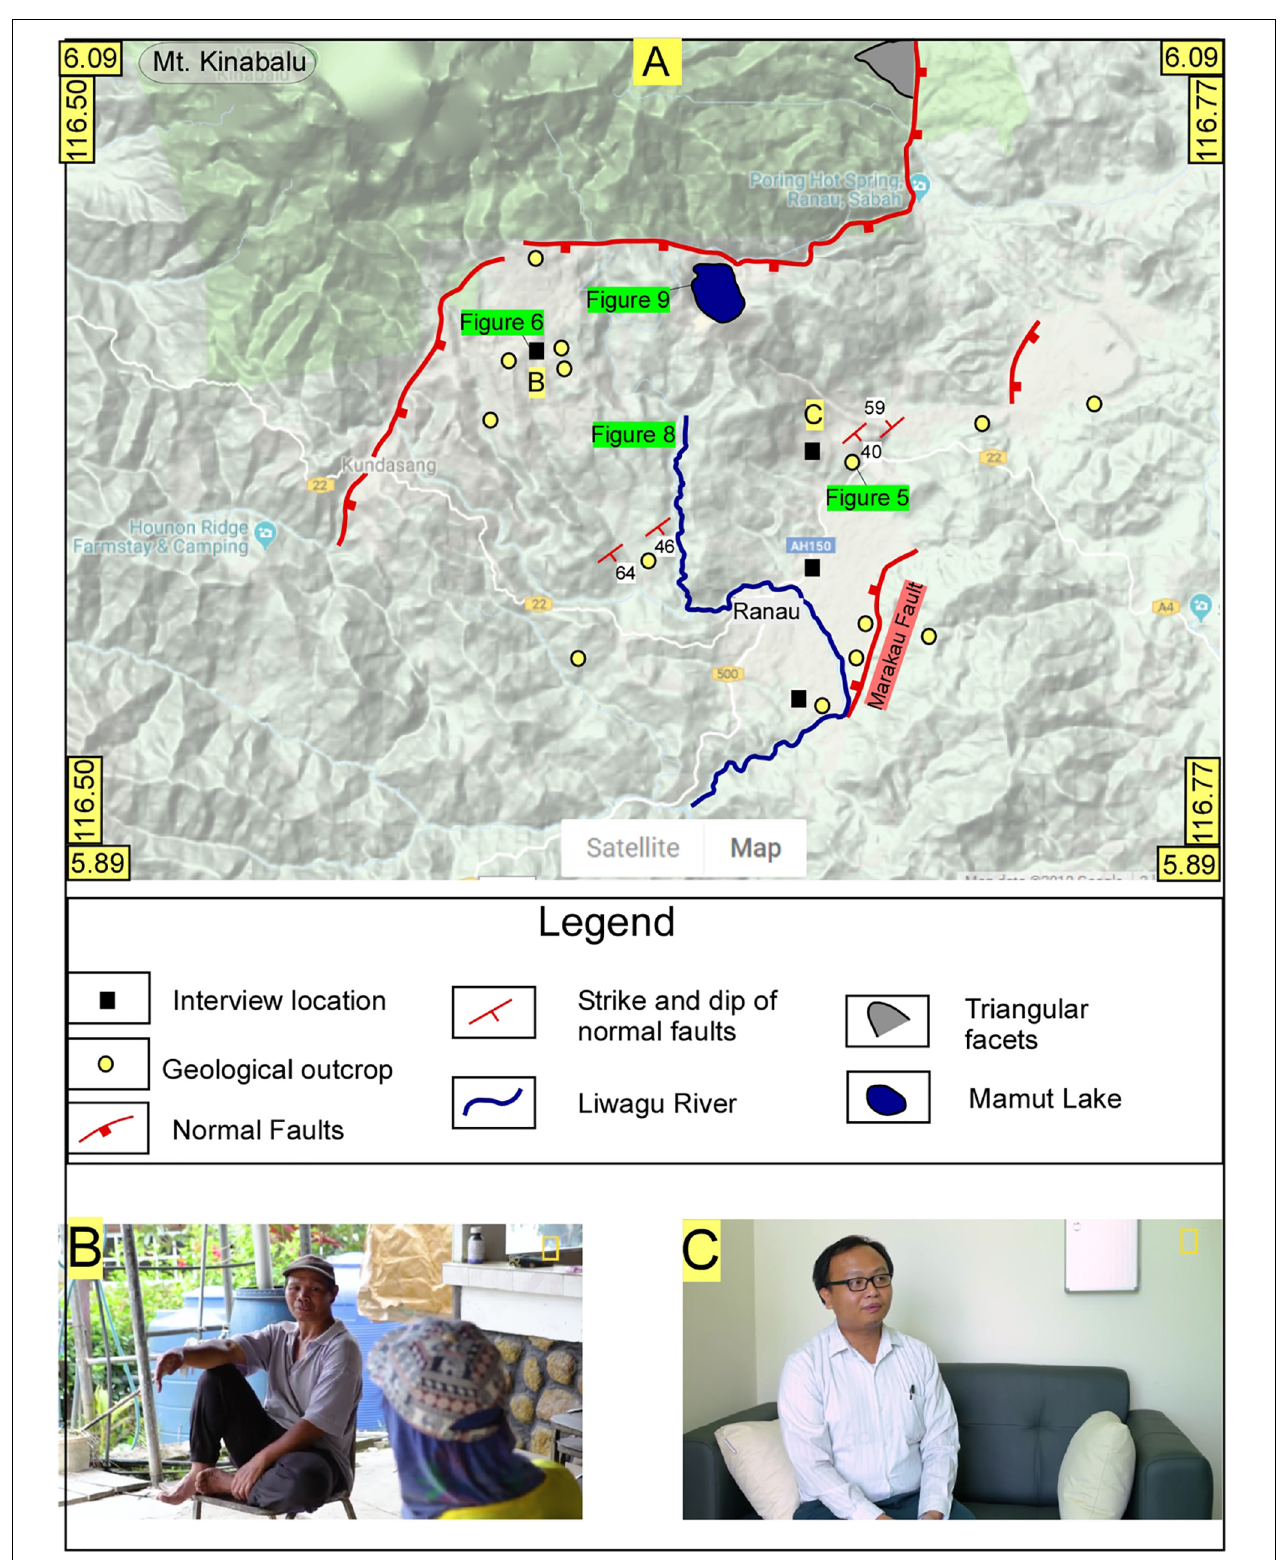
FIGURE 4 | Google terrain map shows the geological field investigation sites (A) and the location of oral interviews (B,C) . Some of the active faults and geological bedrock data are also shown.